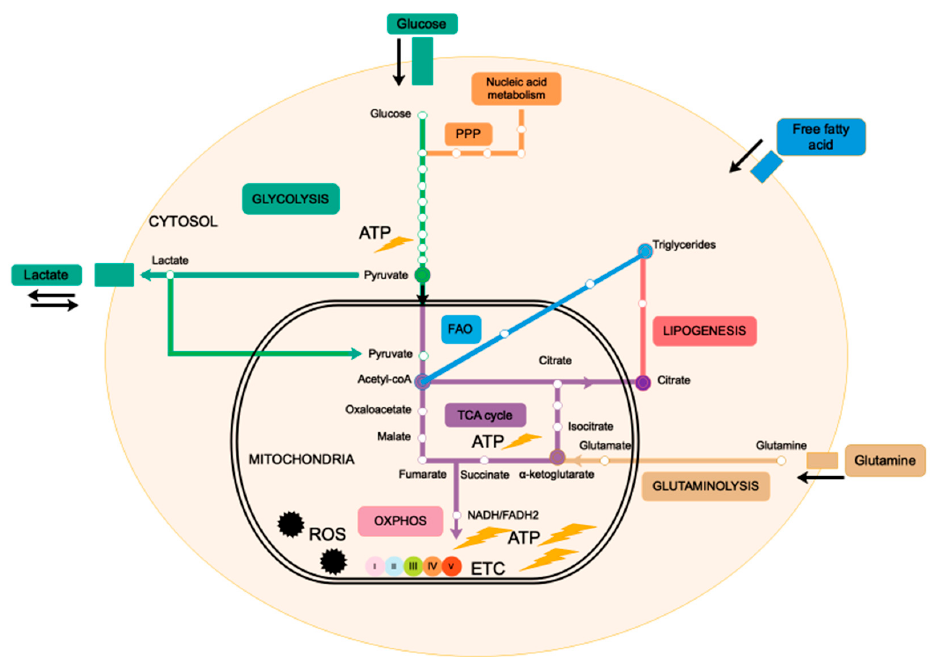
Figure 1. Mitochondrial metabolic pathways. Catabolism of glucose, glutamine and fatty acids all contribute to mitochondrial energetic metabolism. Filled circles represent the intersections between mitochondrial and cytosolic metabolic pathways. Cellular ATP is mainly produced in mitochondria through oxidative respiration that depends on cytosolic glycolysis and mitochondrial TCA cycle. Mitochondrial citrate produced in the TCA cycle contributes to lipid synthesis in the cytosol. TCA cycle and OXPHOS are fueled by pyruvate, glutamate and acetyl-coA produced by glycolysis, glutaminolysis and fatty acid β -oxidation (FAO), respectively. Glycolysis can also contribute to nucleic acid metabolism via the pentose phosphate pathway (PPP). Extracellular lactate can be oxidized in mitochondria and is converted into pyruvate, thereby fueling oxidative respiration to produce